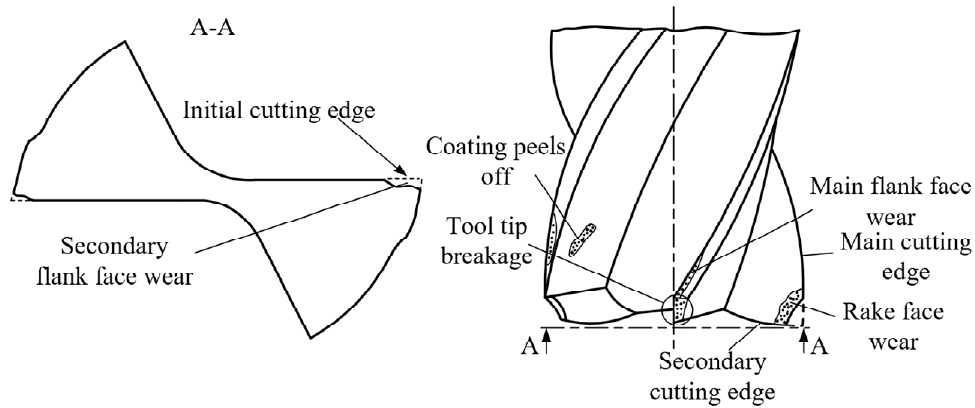
Figure 4. Types of Wear of Micro End Milling Tools.